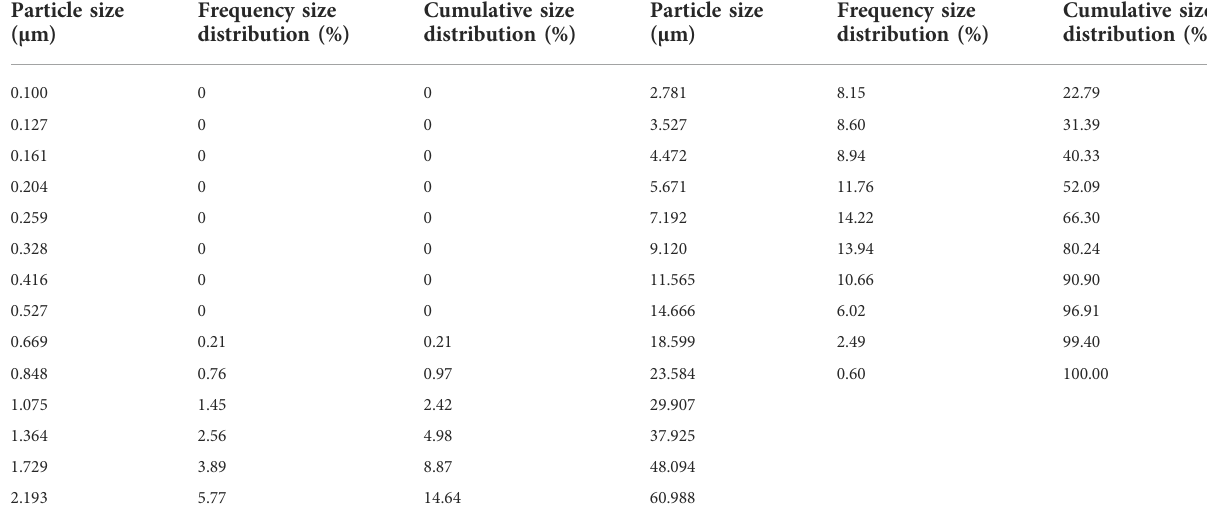
TABLE 3 Particle size distribution of K1000 super fi ne